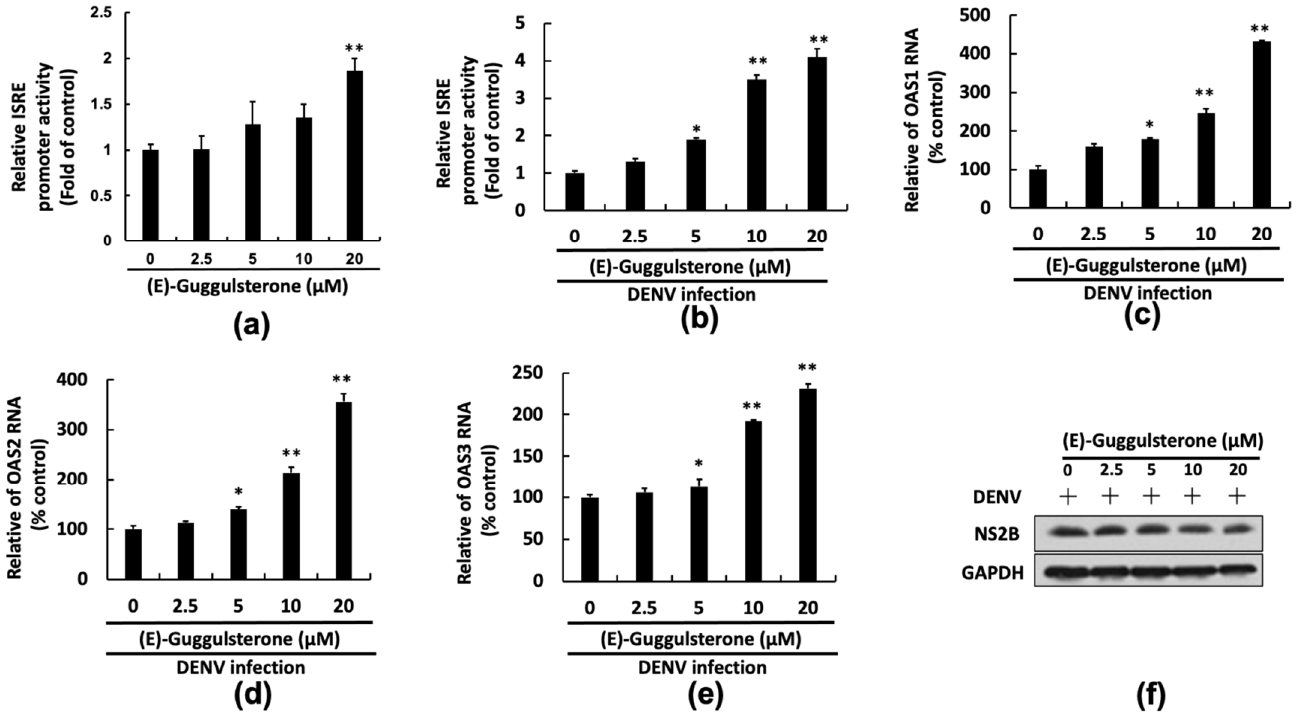
Figure 6. (E)-Guggulsterone induces IFN-mediated antiviral gene expression. ( a , b ) (E)-Guggulsterone induced the ISRE promoter activity in parental Huh-7 and DENV-infected Huh-7 cells. Huh-7 cells were transfected with pISR-Luc and then treated with the indicated concentrations of guggulsterone (0–20 µ M) for 3 days. The relative induction of ISRE promoter activity was determined using a luciferase assay. The relative induction of promoter activity was determined by luciferase assay and presented as fold activation compared to the DENV-infected cells treated with 0.1% DMSO, designed as “0”. (E)-Guggulsterone increased the mRNA levels of ( c ) OAS1, ( d ) OAS2, and ( e ) OAS3 in DENV-infected Huh-7 cells. DENV-infected Huh-7 cells were treated with the indicated (E)-guggulsterone concentrations (0–20 μ M) for 3 days. The mRNA level of OAS1-3 was analyzed using RT-qPCR. The relative percent induction was compared to the DENV-infected cells treated with 0.1% DMSO, defined as 100%. ( f ) (E)-guggulsterone exhibited slightly antiviral activity in Vero.STAT1 KO cells. DENV-infected Vero.STAT1 KO cells were treated with the indicated concentrations of (E)-guggulsterone for 3 days, and the DENV protein levels were analyzed by Western blotting. Here, “0” was regarded as the treatment with 0.1% DMSO. Error bars indicate the mean ± SD of five independent experiments ( n = 5). * p < 0.05, ** p < 0.01.